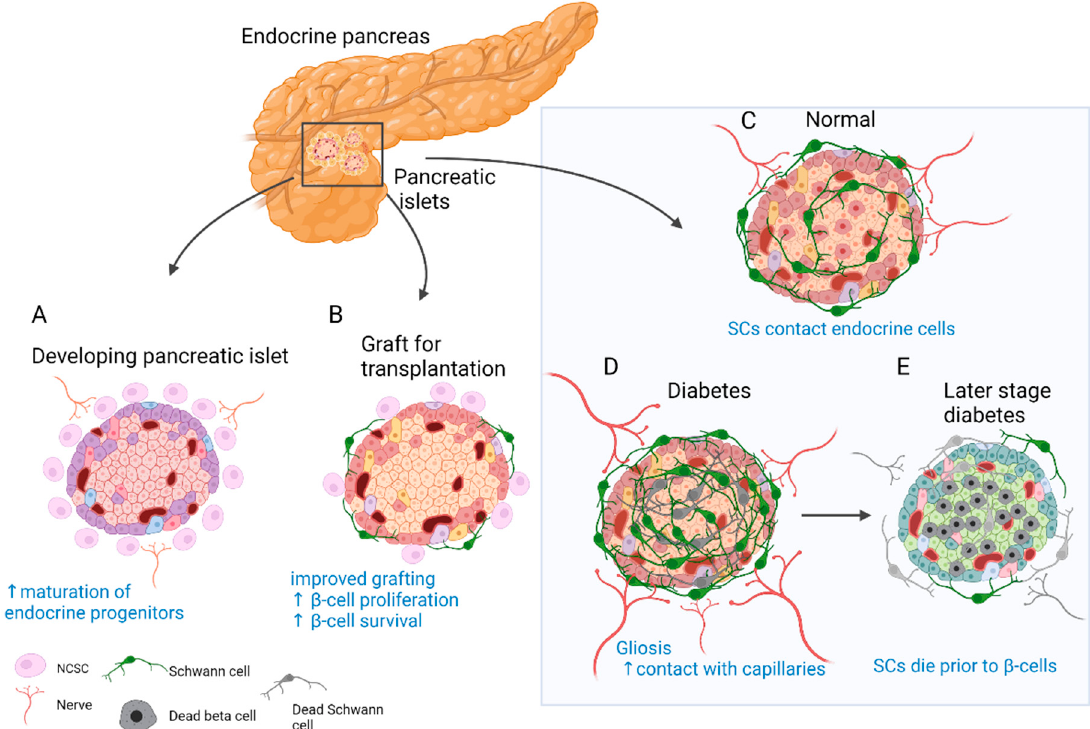
Figure 2. Role of SC and neural crest (NC) cells in the physiology and disease of the endocrine pancreas. ( A ) Reciprocal signalling with endocrine progenitors promotes islet maturation and glial fate choice by NC cells. ( B ) The transplanted islets contain surviving donor SCs. Co-transplantation and coating of endocrine islets with NC stem cell (NCSC)-like cells improve graft function and stimulate β -cell proliferation and survival. ( C ) SCs cover the surface of endocrine islets in mice (to a lesser extent in humans) and make contact with endocrine cells. ( D ) In T2D and insulitis, SCs expand and gliosis is observed. Extensive contacts are detected with capillaries. ( E ) With the onset of T1D SCs die before β -cells and innervation is reduced. SCs might have immunomodulatory function.